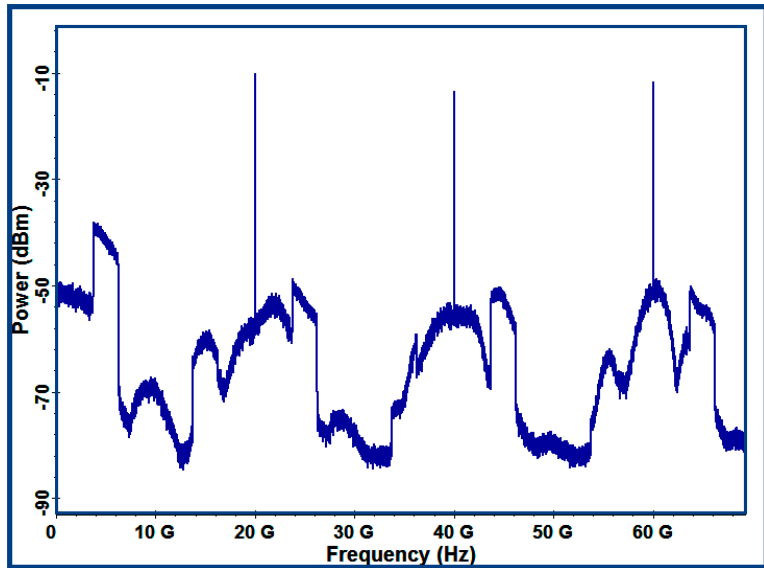
Figure 10. The four simultaneous wireless carriers.